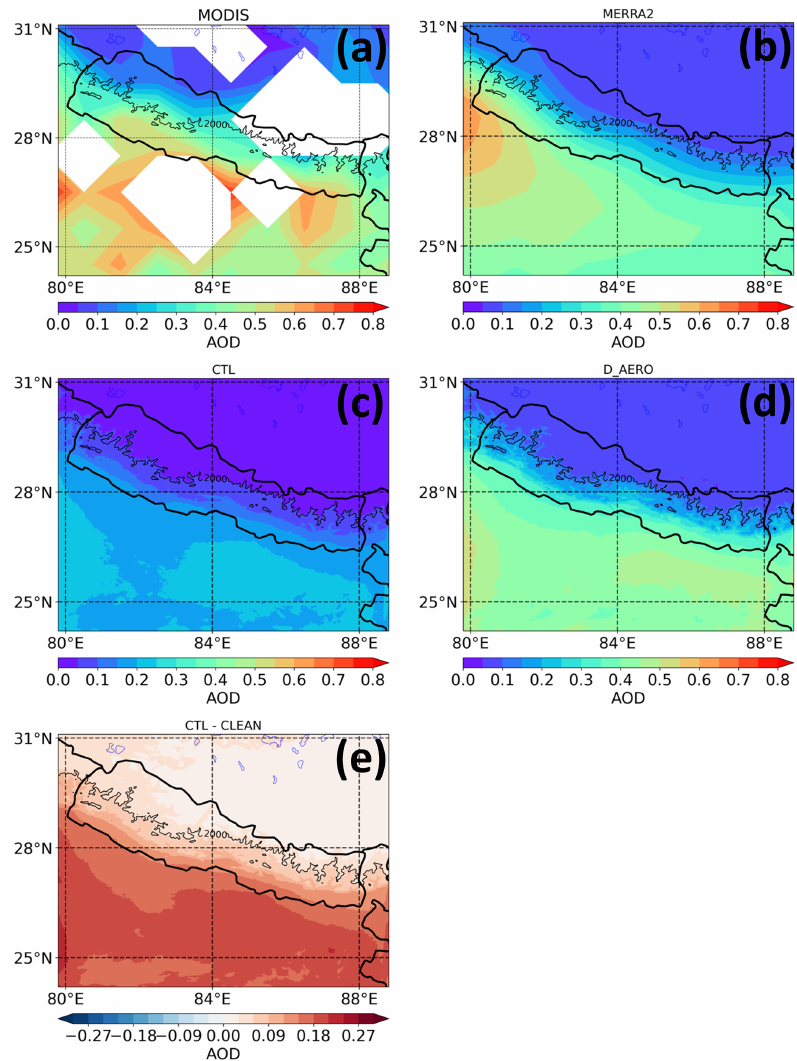
Figure 4. (a) Spatial distribution of mean MODIS (Aqua and Terra averaged), (b) MERRA2, (c) CTL, (d) D_AERO, and (e) the mean differences of AOD between CTL and CLEAN simulations. The black contour represents the terrain elevation of 2000ma.s.l. The missing data in the MODIS product is due to cloud contamination during the retrieval process of aerosol